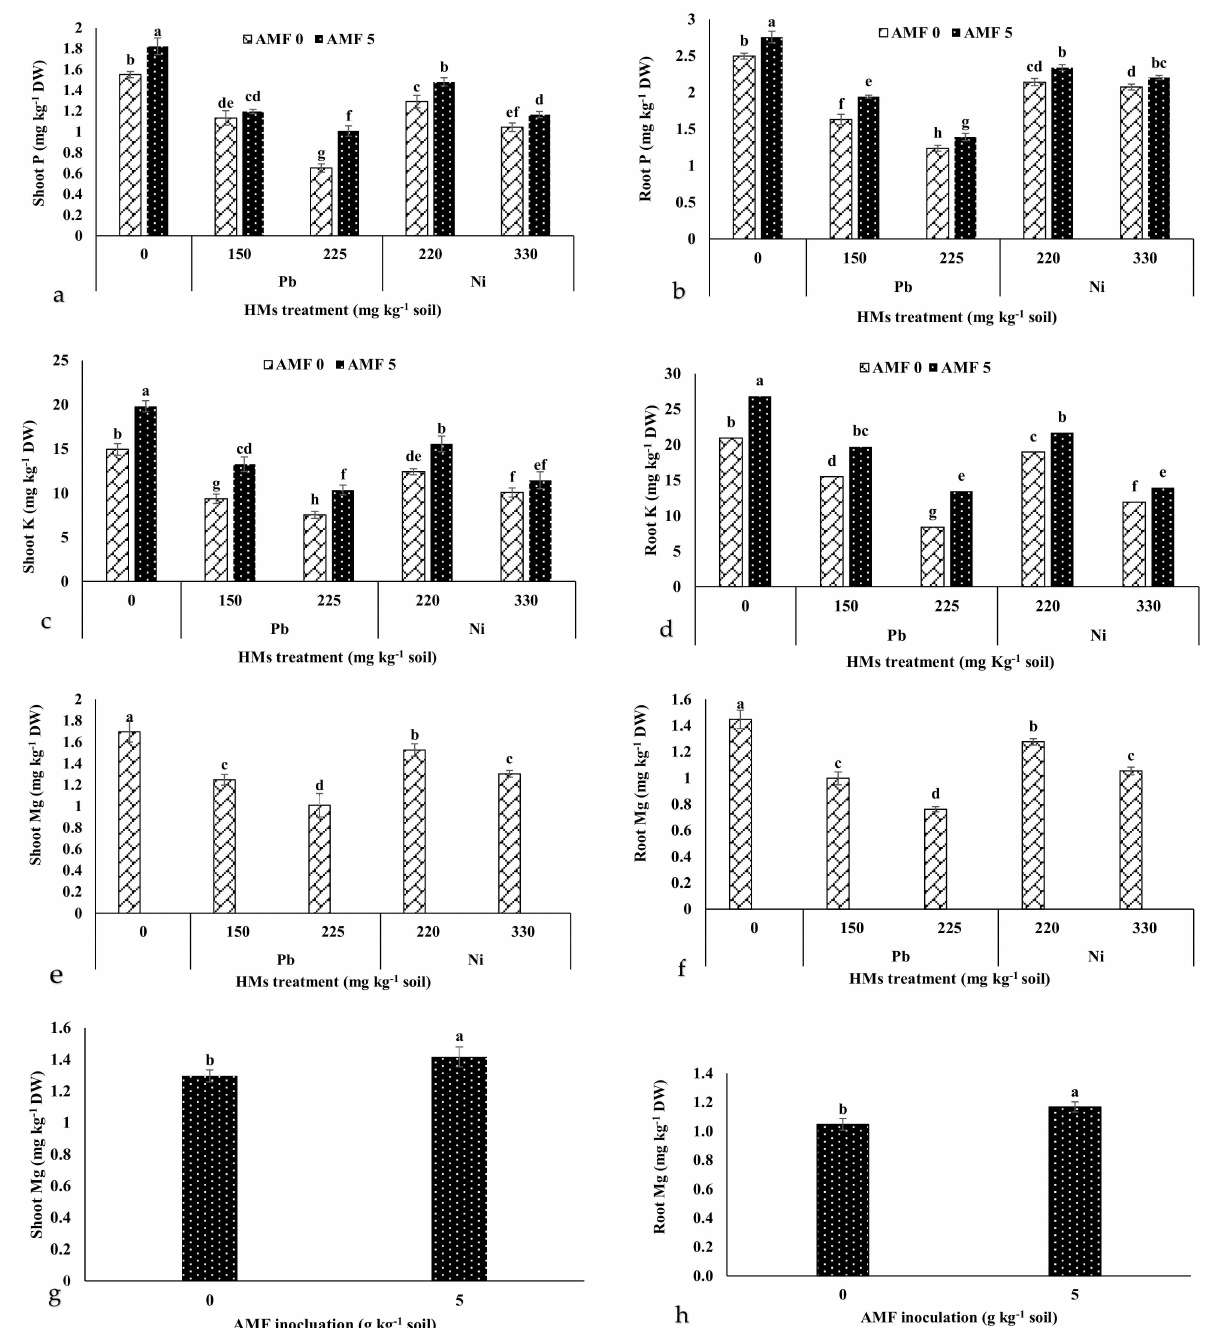
Figure 4. The effect of arbuscular mycorrhizal fungi (AMF) inoculation on the shoot P ( a ), root P ( b ), shoot K ( c ), root K ( d ), shoot Mg ( e ), and root Mg ( f ) content in lavender plant under Pb and Ni (mg kg − 1 soil) heavy metal (HM) stress as well as the effect of AMF inoculation on the shoot ( g ) and root ( h ) Mg content in lavender. Different letters indicate significant differences according to the LSD test at p <